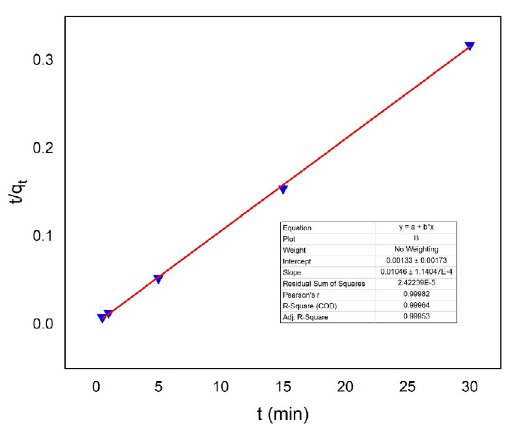
Fig. 9. Adsorption kinetics; pseudo-second-order model.